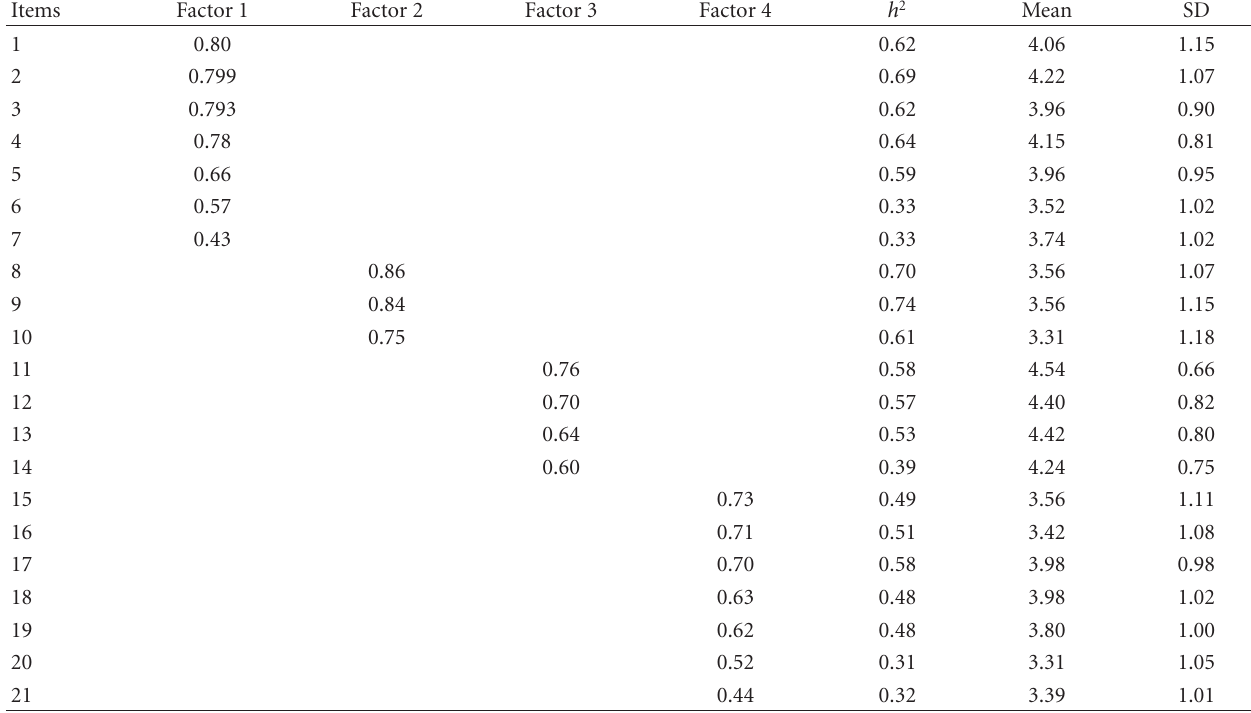
Table 3: Factor loading and communalities ( h 2 ) of the caring teaching scale.